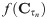
Overview of data generative model.A) Stochastic generation of T. The incorporation time of a nucleotide, τn, is defined as τn-1 + U where U is a random variable with a distribution that describes the kinetics of the DNAP being used. B) Stochastic generation of errors. At each incorporation time τn, an error is generated with probability f(Cτn). Errors in the nucleotide strand are represented by blue regions, correct incorporations are represented by orange regions.